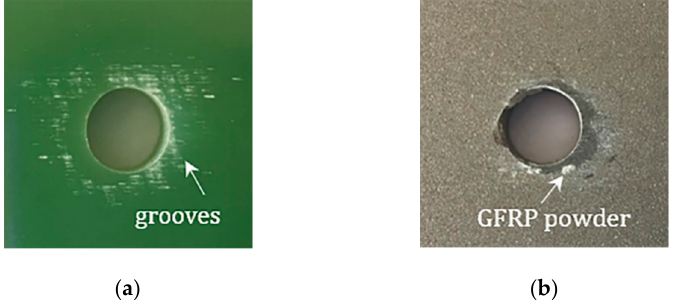
Figure 8. Plate surfaces of G-S24# connection after shear test. ( a ) GFRP connecting plate surface after shear test; ( b ) stainless-steel cover plate surface after shear test.